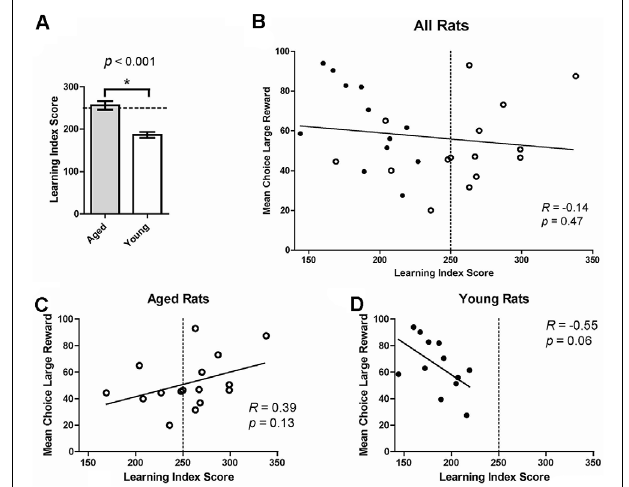
FIGURE 3 | (A) Mean learning index score (LIS) by age group. Aged rats had significantly higher LISs (indicating poorer spatial memory) compared to young rats, even when collapsing aged impaired and unimpaired groups (one-tailed independent t -test, t (26) = 5.23, p < 0.0001). (B) The Mean choice of large reward collapsed across all probability blocks on the probability discounting task (%, Y-axis) correlated to LIS on the water maze (X-axis). No significant relationship was observed between choice behavior on the probability discounting task and water maze performance (Pearson correlation, R = − 0.14, p = 0.47). The dotted line represents the threshold after which (to the right) rats are considered impaired on the water maze. Open circles: aged rats, n = 16; Closed circles: young rats, n = 12. (C) Relationship between risky choice and water maze performance for aged rats. No statistically significant relationship was found between these two variables (Pearson correlation, R = 0.39, p = 0.13). (D) Relationship between risky choice and water maze performance for young rats. No significant relationship was found between these two variables (Pearson correlation, R = − 0.55, p = 0.06) although a trend is suggested. * p <